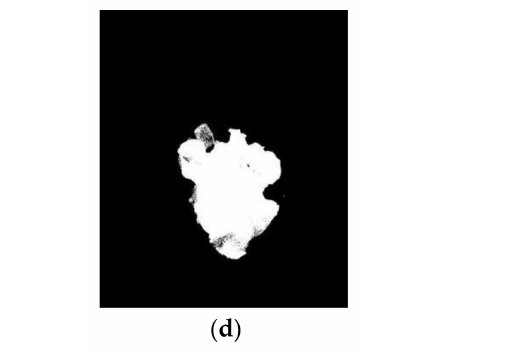
Figure 3. Lettuce canopy outdoor image processing. ( a ) Outdoor canopy images. ( b ) Selected areas for each section. ( c ) Hyperspectral reflectance of different regions. ( d ) Binarized